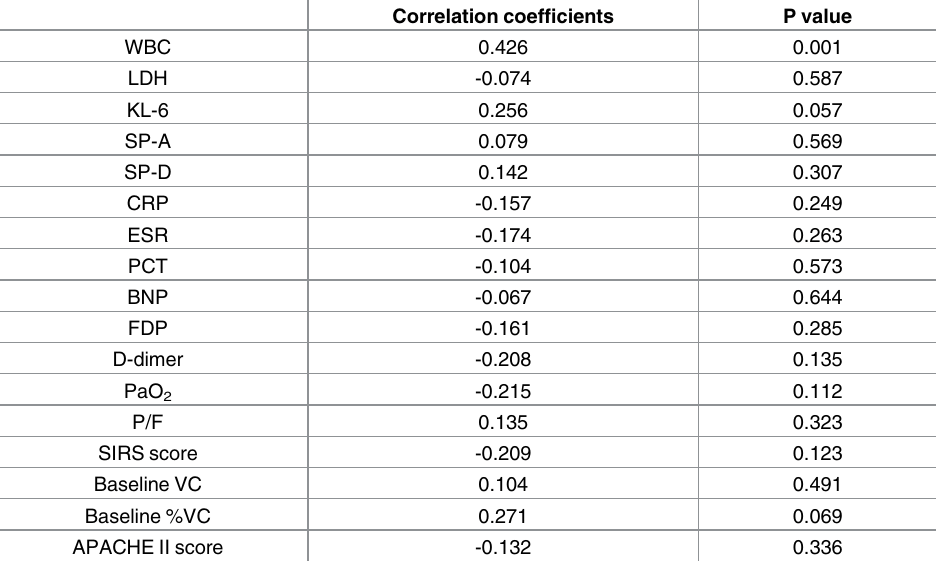
Table 2. Correlations of serum syndecan-4 levels on admission with clinical